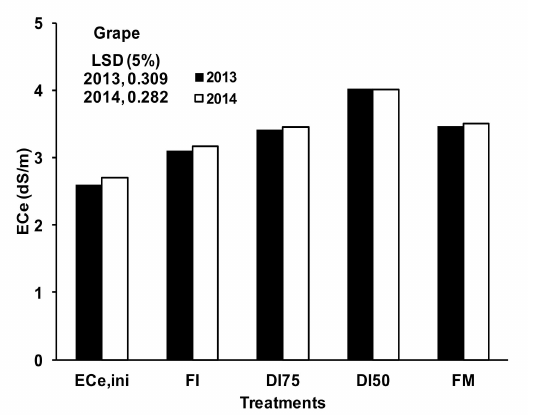
Figure 4. Values of soil salinity (ECe, dS/m) before (initial) and at the end of the irrigation season of orange, table olive, and grapevine in 2013 and 2014 for full (FI), deficit (I75, DI50), and grower’s (FM) irrigation